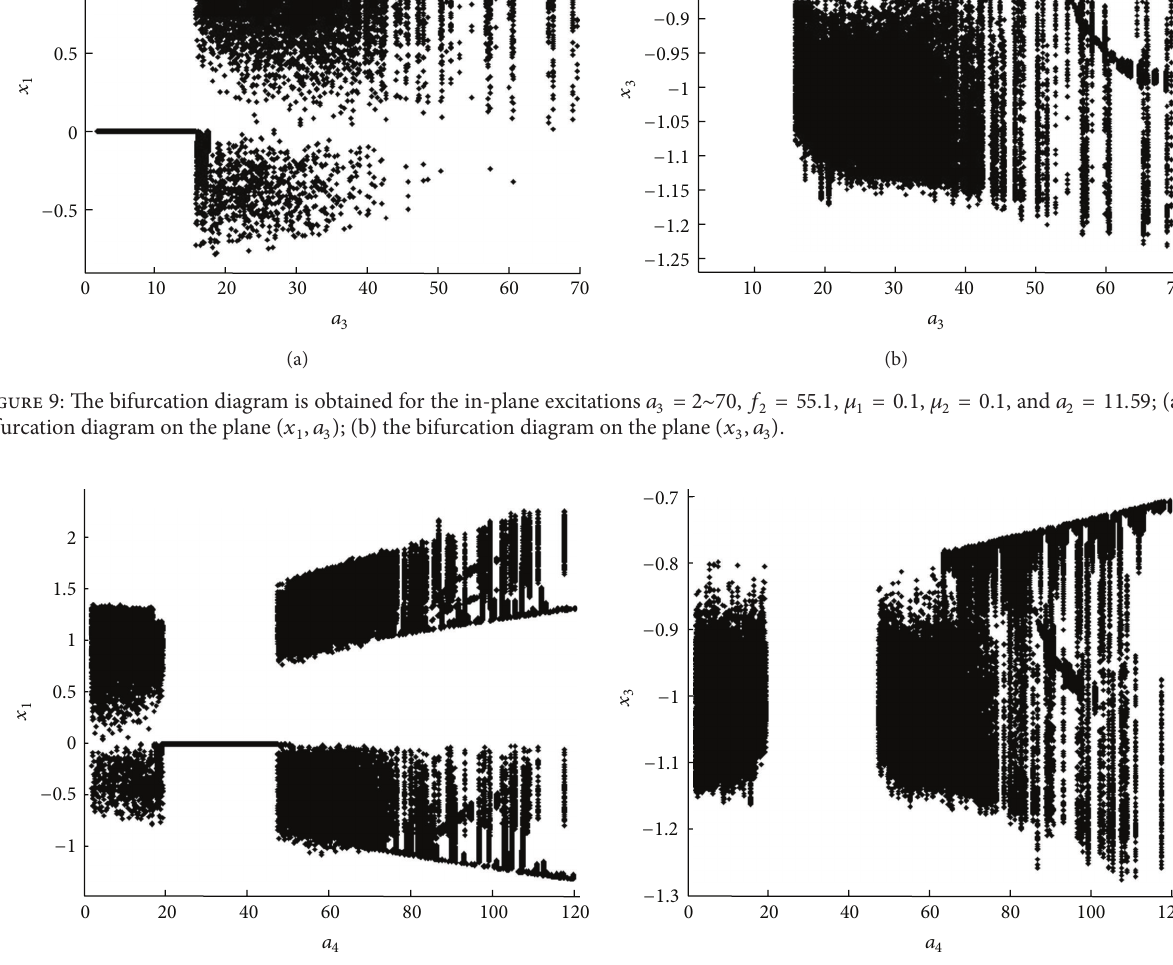
, 𝑎 ) ; (b) the bifurcation diagram on the plane (𝑥 1 4